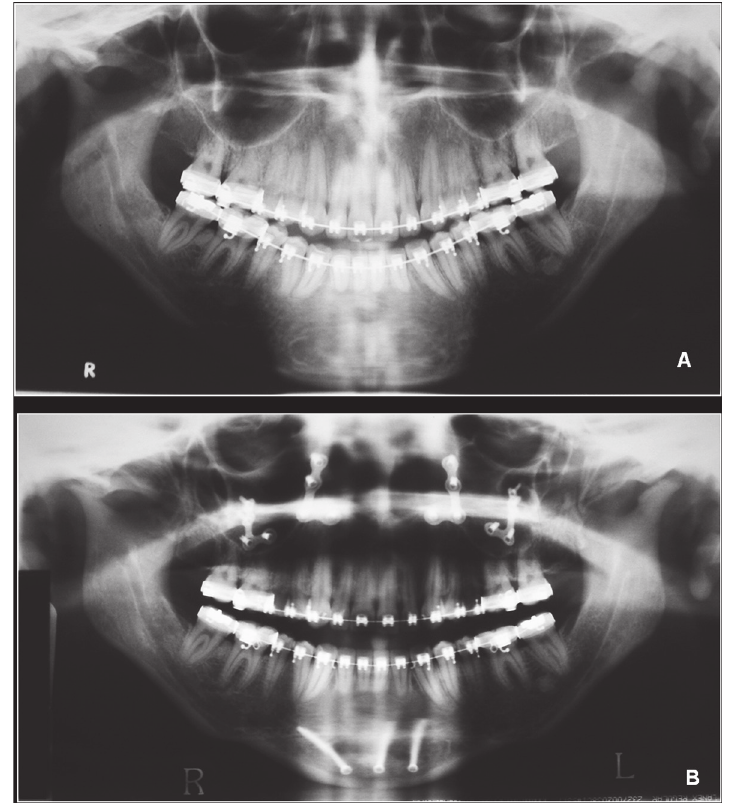
Figure 5- Sequence of figure 6 presenting panoramic images before (A) and after (B) surgery showing the pre-existing juvenile idiopathic arthritis and the deterioration after surgery